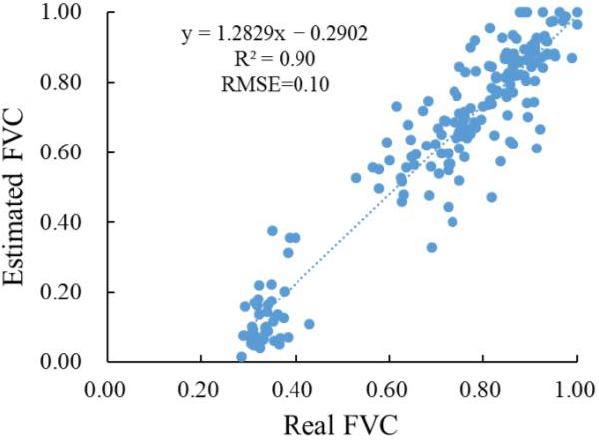
Figure 4. Scatter plot of fused NDVI and real NDVI and correlation coefficient.